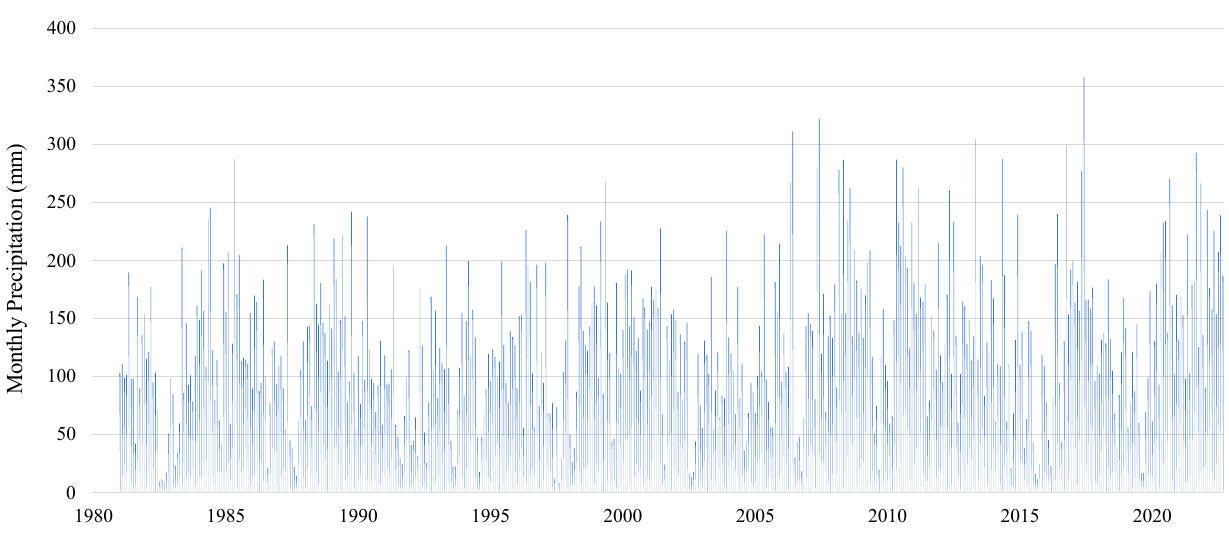
Figure 5. Monthly precipitation trend in the study area